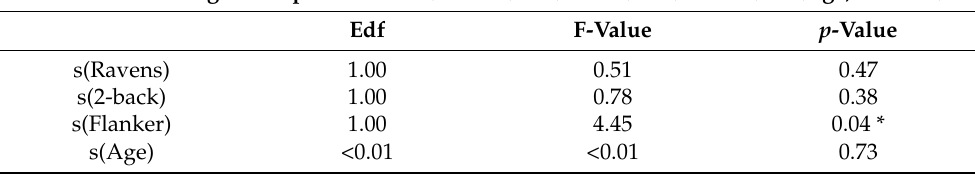
Table A6. Output of the generalized additive model for the English literacy